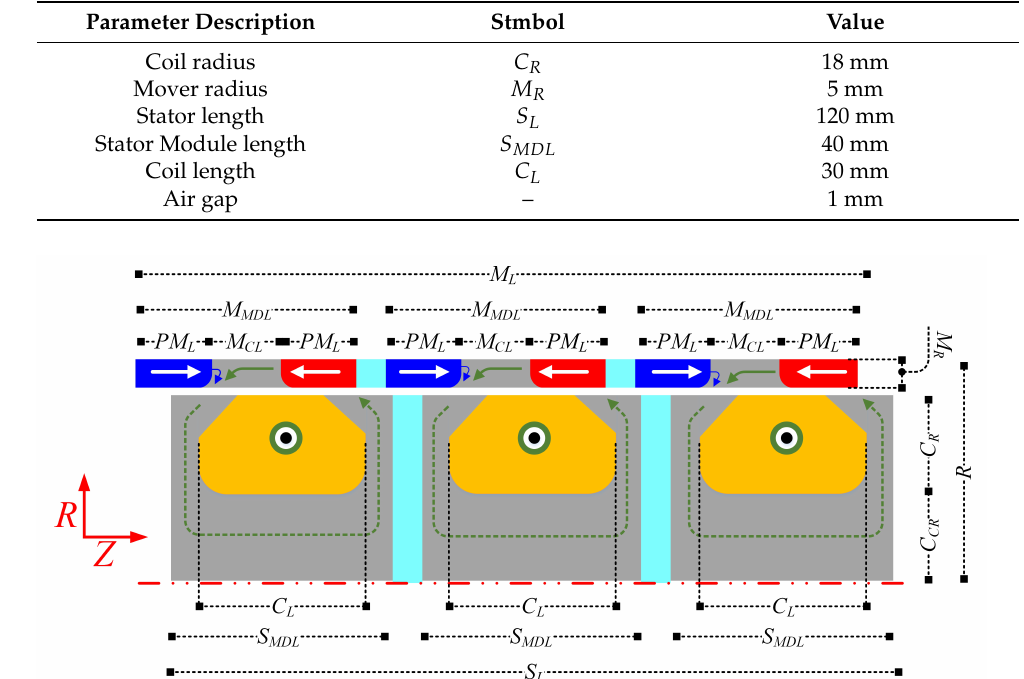
Figure 4. Illustration of parameters of the proposed TMM-LOA.